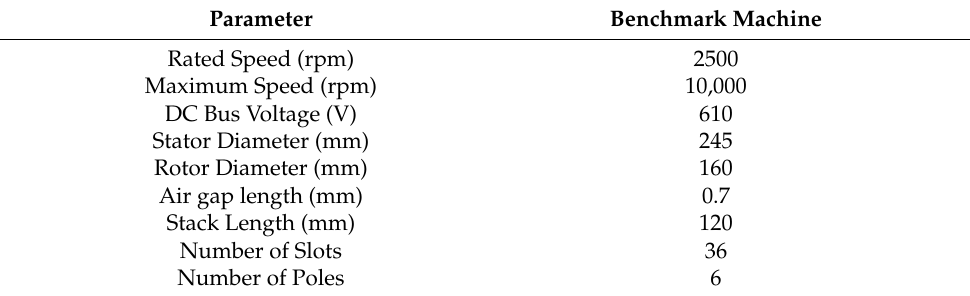
Table 1. Specifications of the benchmark